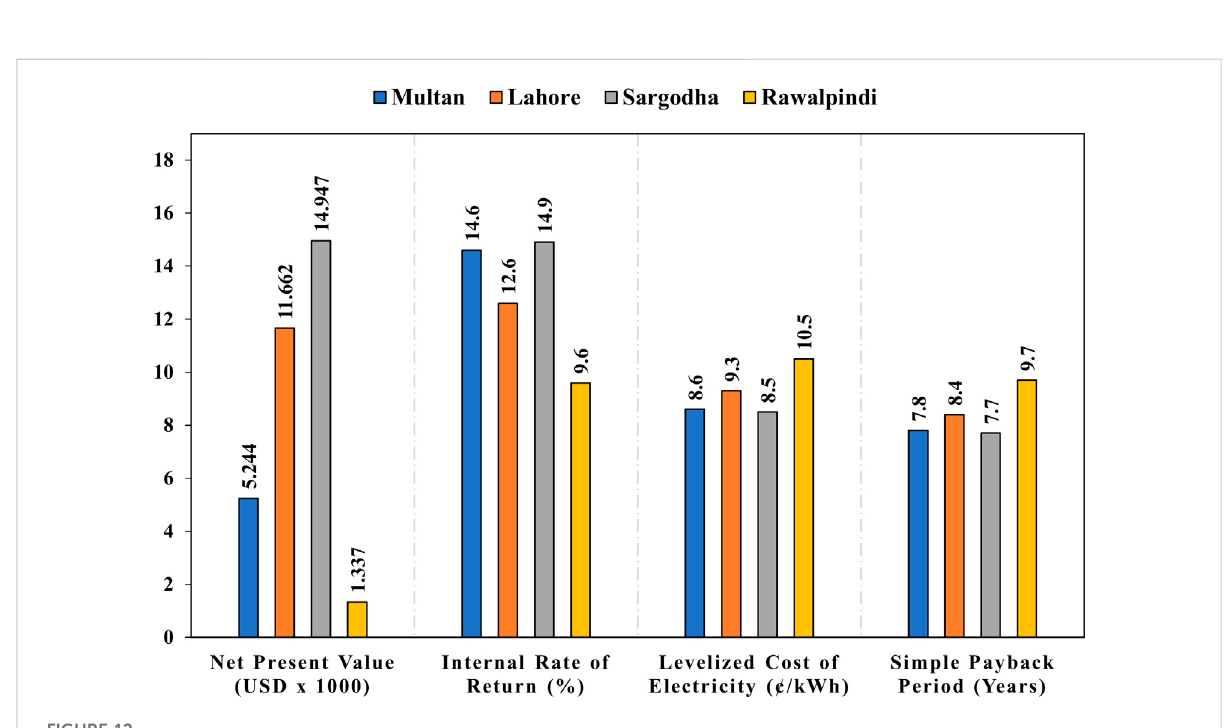
FIGURE 12 Comparison of PV projects based on fi nancial output